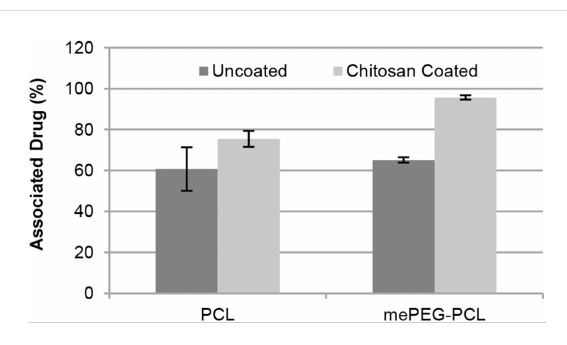
Figure 4: Docetaxel encapsulation efficiency of nanoparticle formula- tions ( n = 3, ± SD).